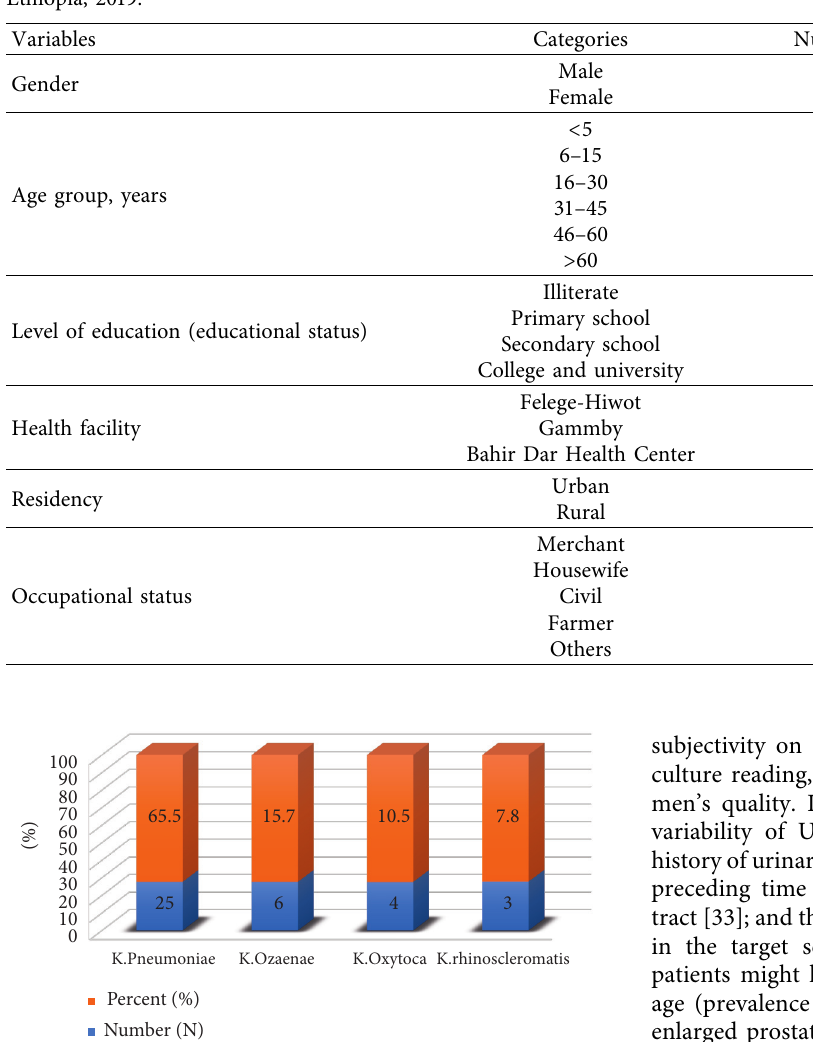
Figure 1: Distribution of Klebsiella species isolated from UTI- suspected patients who attended Bahir Dar City health institutions, Bahir Dar, Northwest Ethiopia, K. ozaenae (4, 10.5%) and K. rhinoscleromatis (3, 7.9%) were